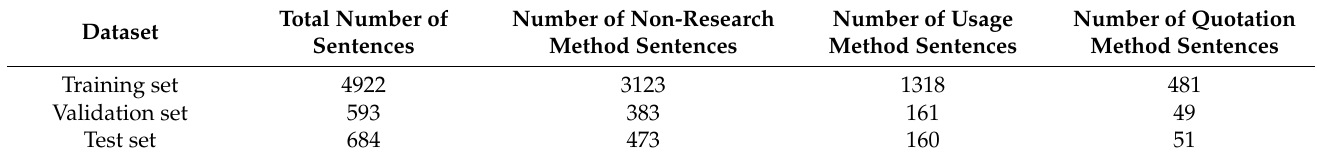
Table 2. Statistical information from the research method